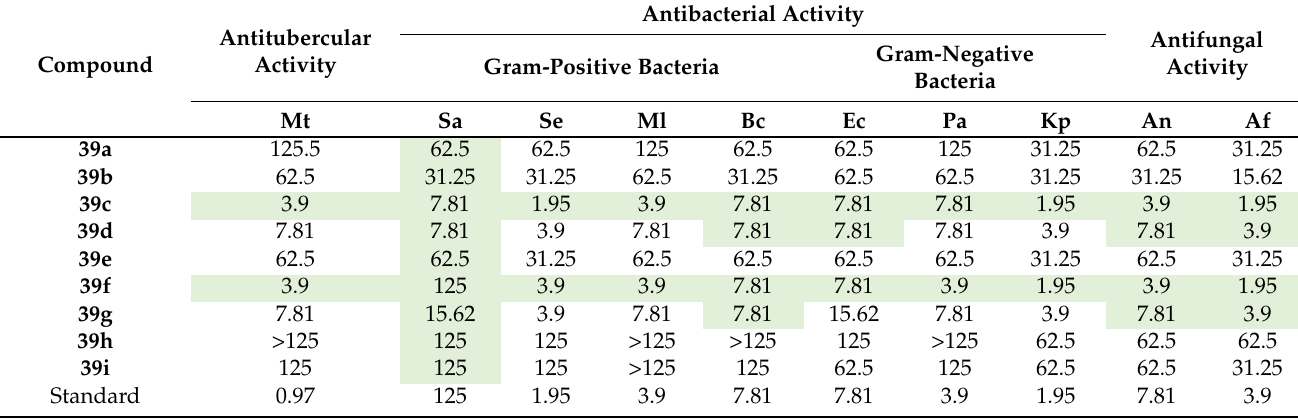
Table 3. Minimum inhibitory concentration ( µ g mL − 1 ) of the compounds 39a – 39i